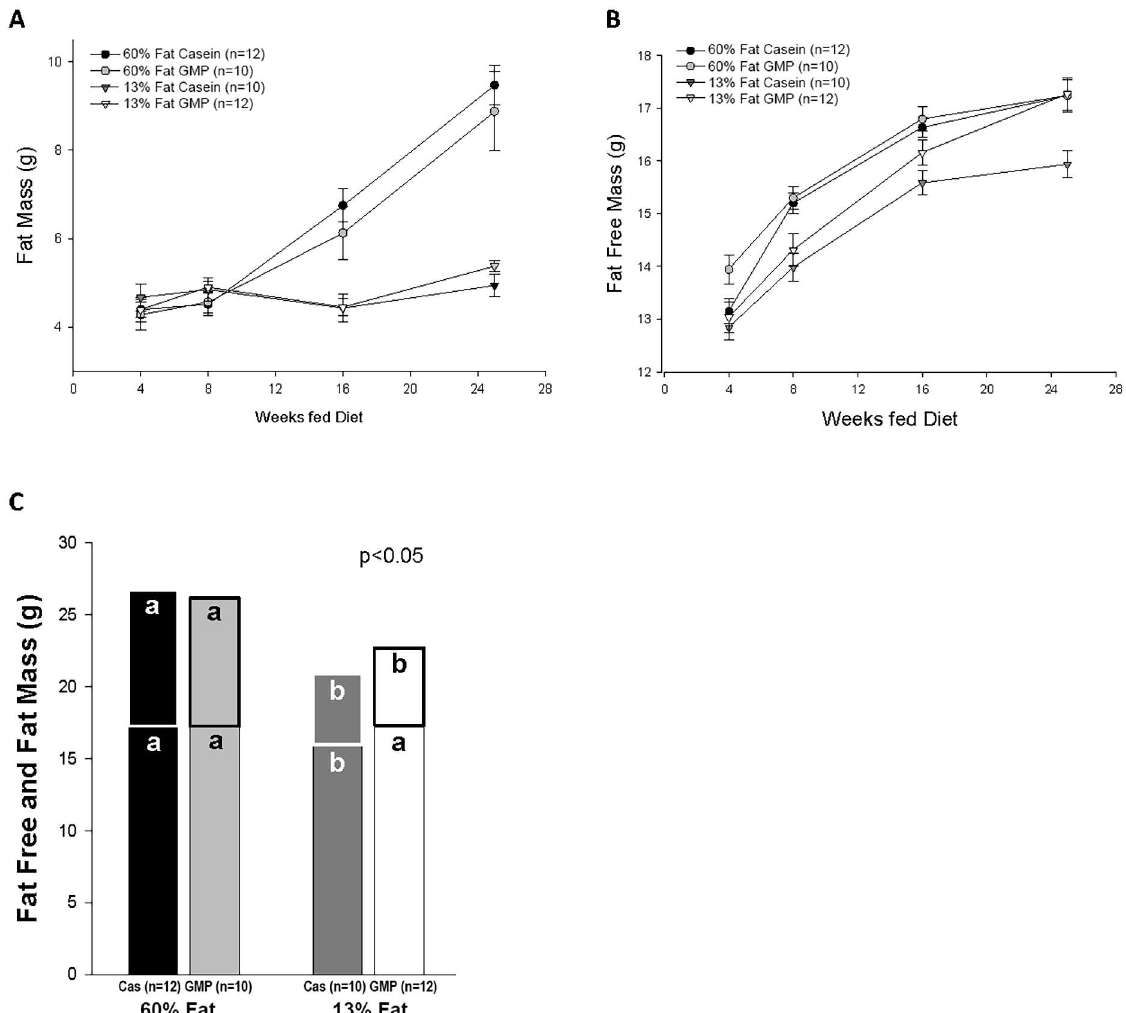
Fig 2. Body composition of female mice. Body composition of fat mass and fat-free mass over time determinedby dual-energy X-ray absorptiometry in mice fed 60%-fat casein, 60%-fat GMP, 13%-fat casein, and 13%-fat GMP diets (A and B). Final compositionof fat-free and fat-mass was assessed (C). a,b Means with different superscriptedletters are significantly different (p < 0.05). Repeatedmeasures analysis of fat mass over time showed a significant fat * time interaction (p < 0.0001). Repeated measures analysisof fat-free mass over time showed a significant prot * fat * time interaction(p < 0.0001).There was a significant fat effect for final fat mass where mice fed the high-fat diets had greater fat mass than mice fed the control diets (C). There was a significant protein * fat interactionfor final fat-free mass where mice fed the 13%-fat casein diet had a lesser fat-free mass than mice fed the other three diets. Nos. in parentheses indicate sample size.